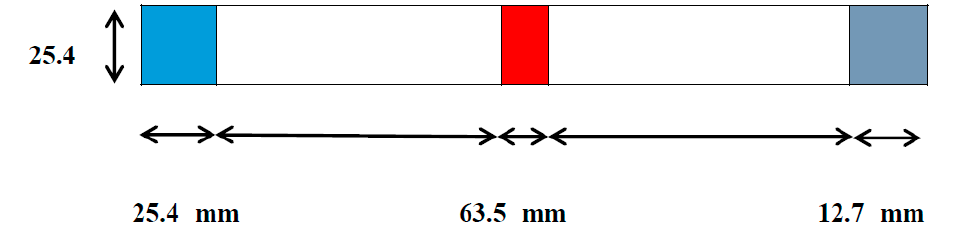
Figure 20. Aluminum specimen of ASTM STANDARD D1002-05.